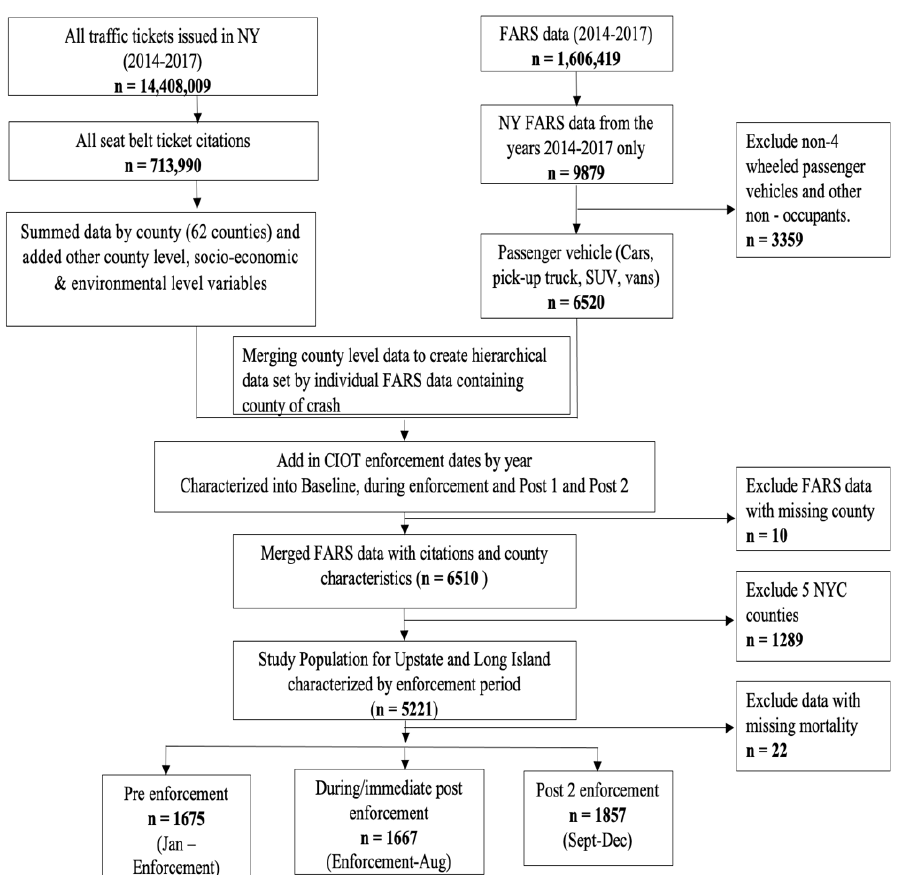
Figure 1. Study Population Flow Diagram. The inclusion and exclusion criteria employed to identify the study population from New York State (NYS) motor vehicle ticketing data and the Fatality Analysis Reporting System (FARS) is shown for the Upstate and Long Island regions of NYS.